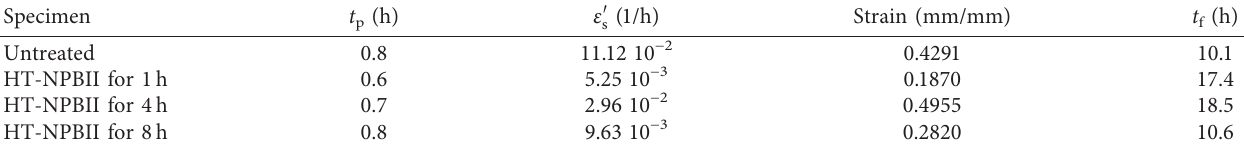
Table 2: Creep data at 500 ° C and 35MPa of untreated Nb and specimens treated by HT-NPBII for 1h, 4h, and 8 h.